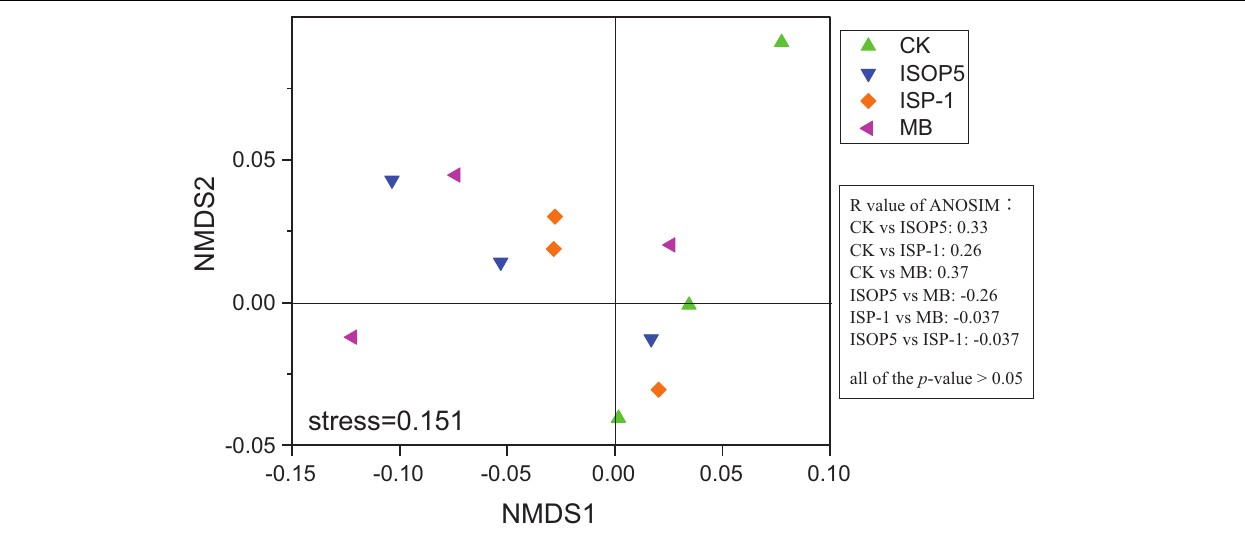
FIGURE 1 | Non-metric multidimensional scaling (NMDS) plots of bacterial community composition in soils with and without bacteria inoculums. ANOSIM showed non-significant differences ( p > 0.05) between treatments ( R = degree of separation between test groups ranging from -1 to 1; R = 0, not different; R = 1, completely different; p -values were based on 9999 permutations). CK: fertilized with basic fertilizer containing NPK fertilizers and composted cow manure; B. cepacia ISOP5: fertilized with basic fertilizer and then applied with suspension of strain B. cepacia ISOP5; R. palustris ISP-1 : fertilized with basic fertilizer and then applied with suspension of strain R. palustris ISP-1; MB: fertilized with basic fertilizer and then applied with suspensions of B. cepacia ISOP5 and R. palustris ISP-1.